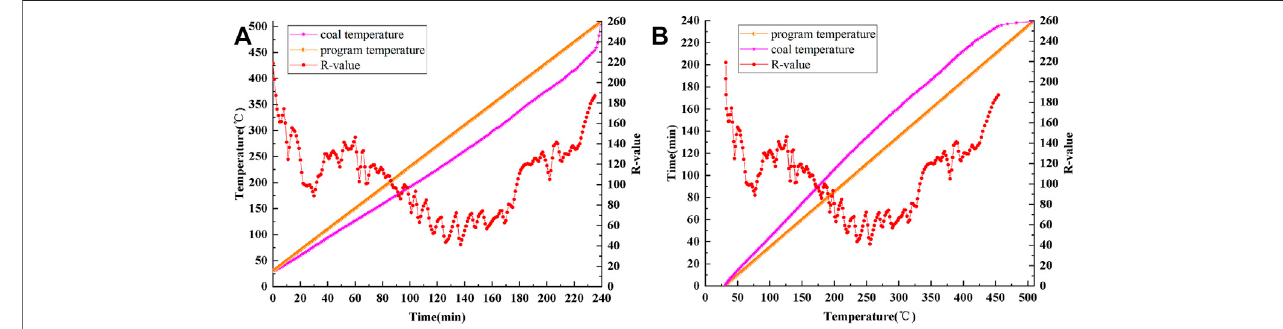
FIGURE 2 | Curves of program temperature, coal temperature and R-value: (A) time-varying, (B) temperature-varying.